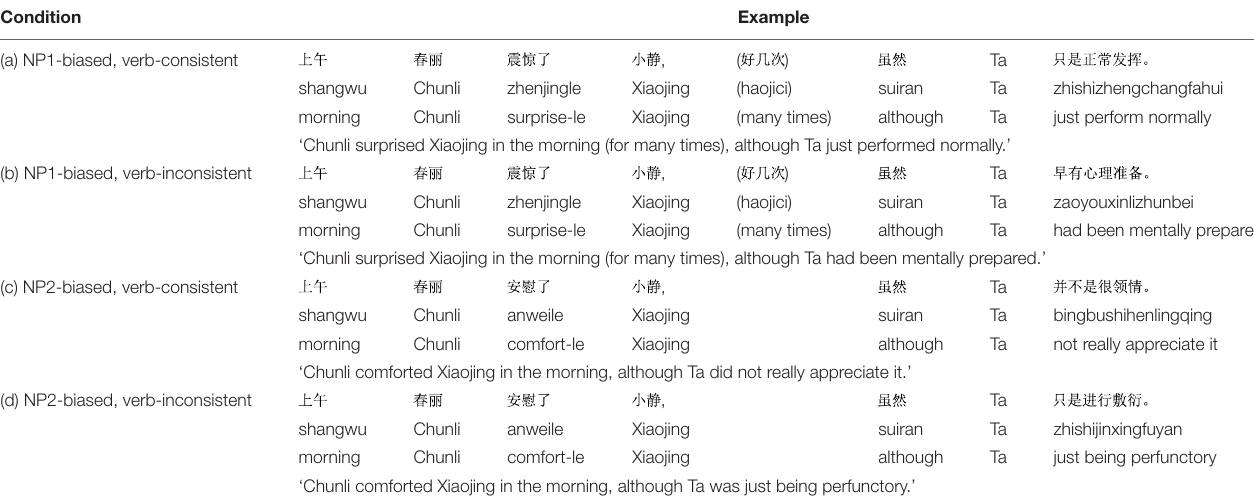
TABLE 5 | Example stimuli in Experiments 2 and 3. Condition Example